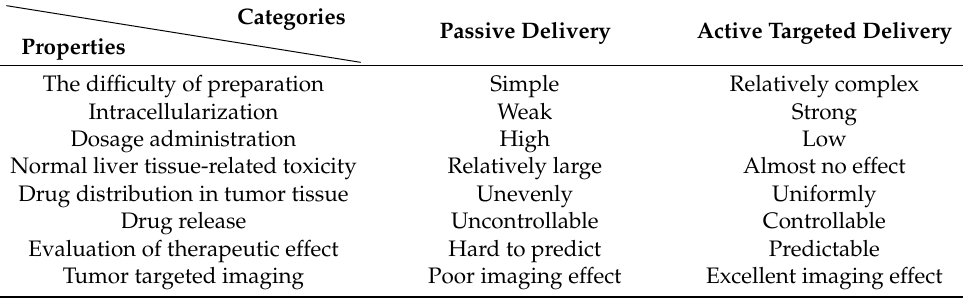
Table 1. Comparison of characteristics of passive delivery and active targeted